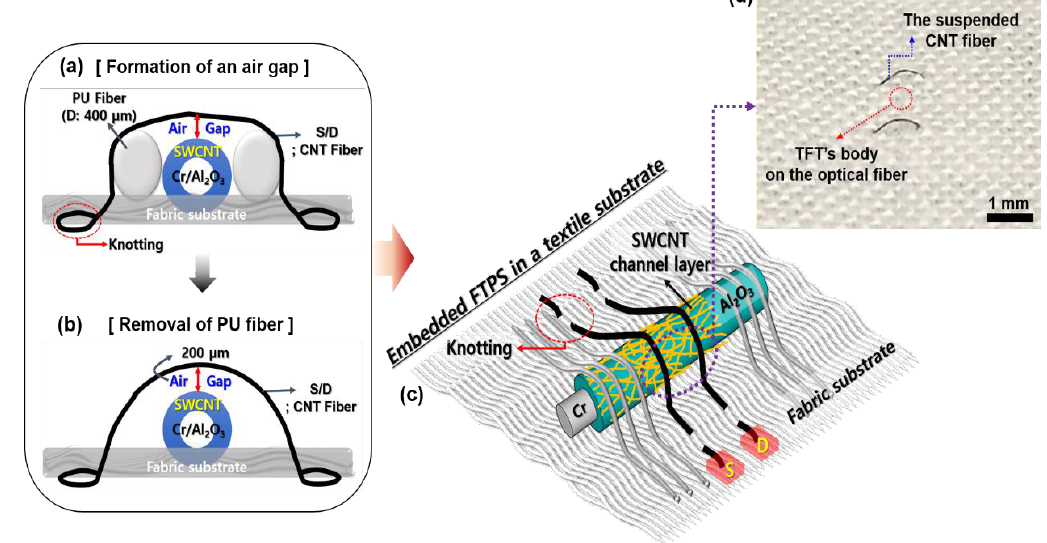
Figure 2. Schematic of the fabrication process the fiber transistor-type pressure sensors (FTPS); ( a ) Formation of an air gap with sacrificial PU fibers and a sewing process, and ( b ) the FTPS structure after removing of the PU fibers. ( c ) Schematic illustration of the embedded FTPS in a textile substrate with the suspended CNT fibers. ( d ) A photograph of the practical FTPS showing the TFT’s body and the suspended CNT fiber.